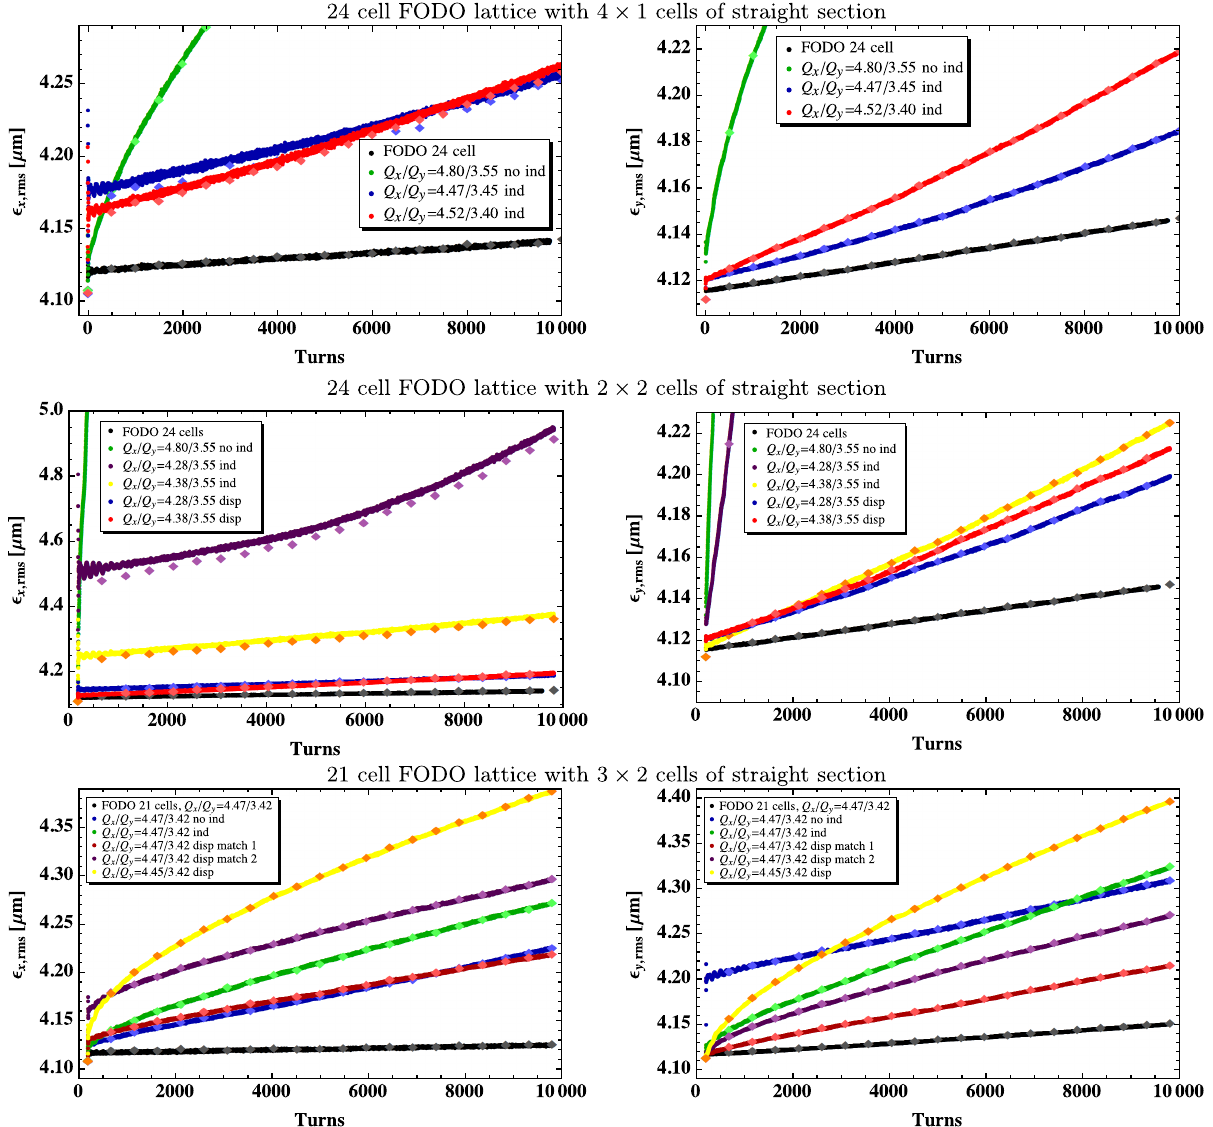
FIG. 27. Time evolution of horizontal (left) and vertical (right) rms emittance for the 24-cell FODO lattice with 4 × 1 (top), 24-cell FODO lattices with 2 × 2 cells (center) and 21-cell FODO lattices with 3 × 2 cells of straight section (bottom) with only two quadrupole families (no ind), with additional individual quadrupoles for beta-beating correction (ind) and with a half missing bend dispersion suppression scheme (disp), the latter only for 24-cell FODO lattices with 2 × 2 cells and 21-cell FODO lattices with 3 × 2 cells of straight section. For comparison also the time evolution of the emittance of the regular 24- and 21-cell FODO lattice is shown (FODO 24 cells and FODO 21 cells). The values indicated with diamonds are the emittances calculated including the second order dispersion. For all simulations the initial distribution has been created taking only the linear dispersion into